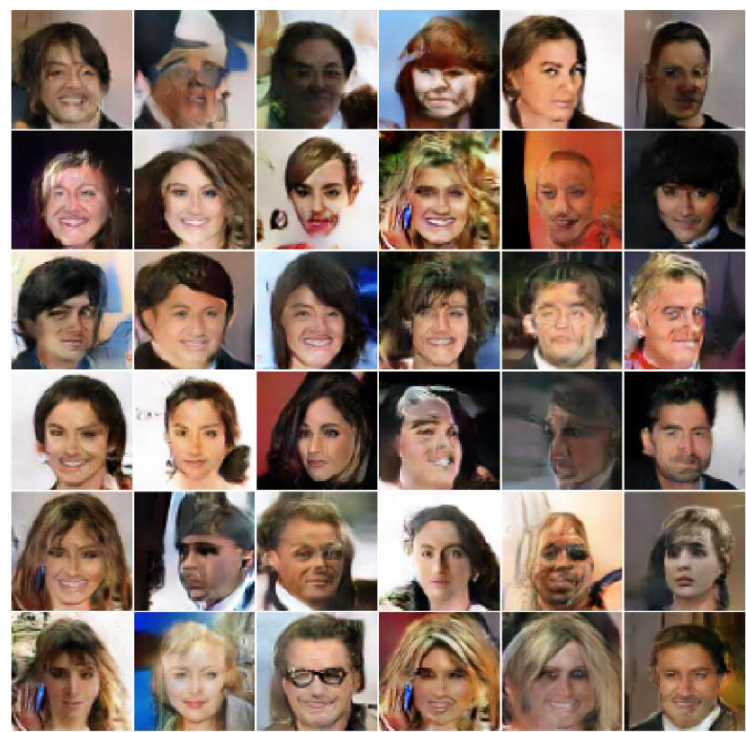
Figure 10. Representative images of EBGAN (Energy-Based Generative Adversarial Network) [41].